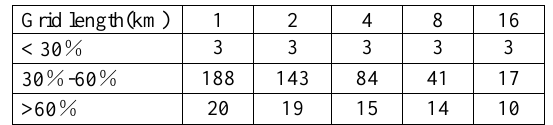
Table 4. Statistical results of space distribution box